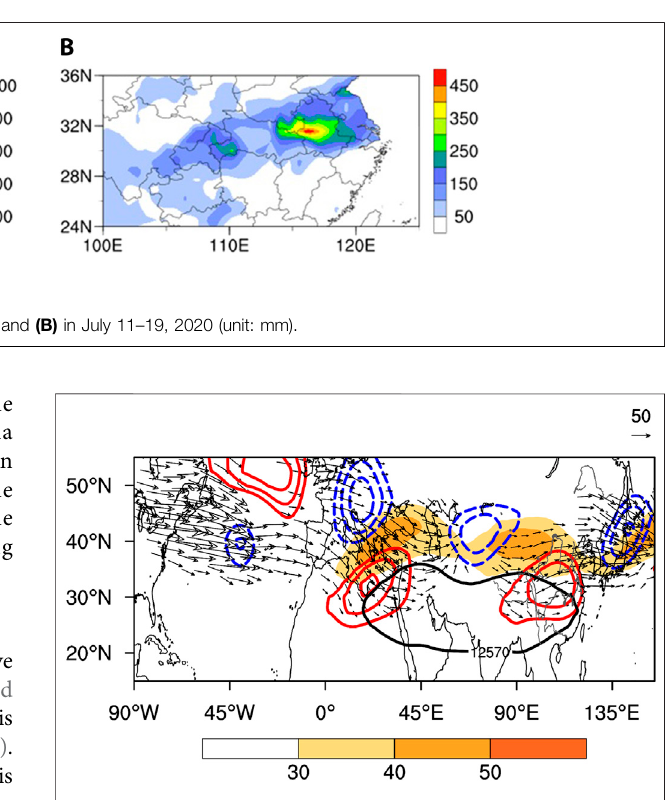
FIGURE 2 | The geopotential height anomaly (contours, unit: gpm), the wave-activity fl ux (arrow, unit: m 2 s − 2 ) and wind velocity (shading, unit: m s − 1 ) at 200 hPa during July 11 – 19, 2020. The red contour denotes the positive anomaly of geopotential height, the blue denotes the negative, and the black contour denotes of the SAH. The shaded area is the westerly jet with wind speed ≥ 30 m s − 1